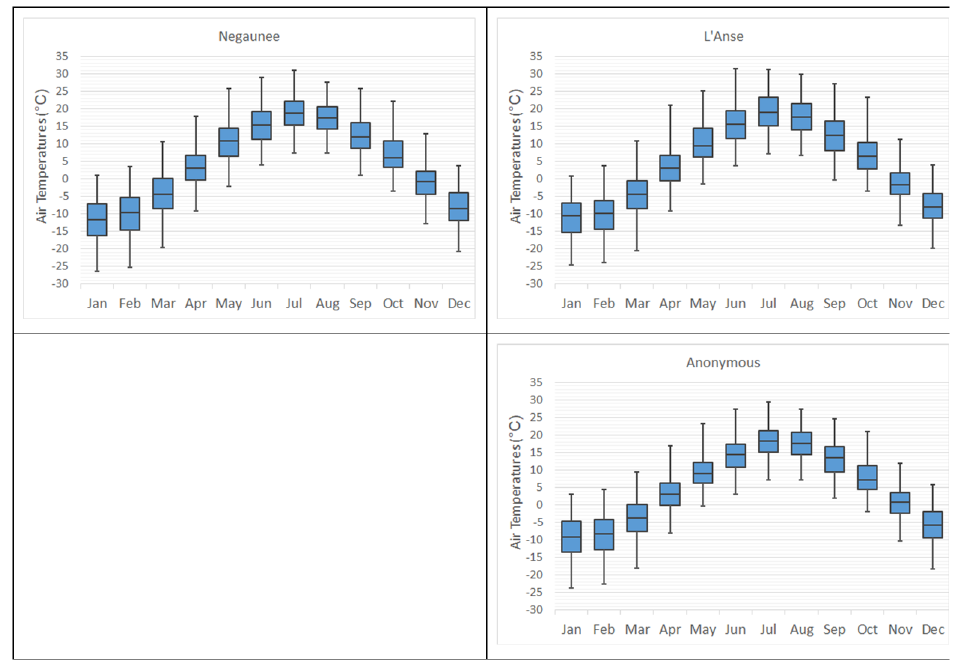
Figure A2. Monthly wind speed distributions for each case study.